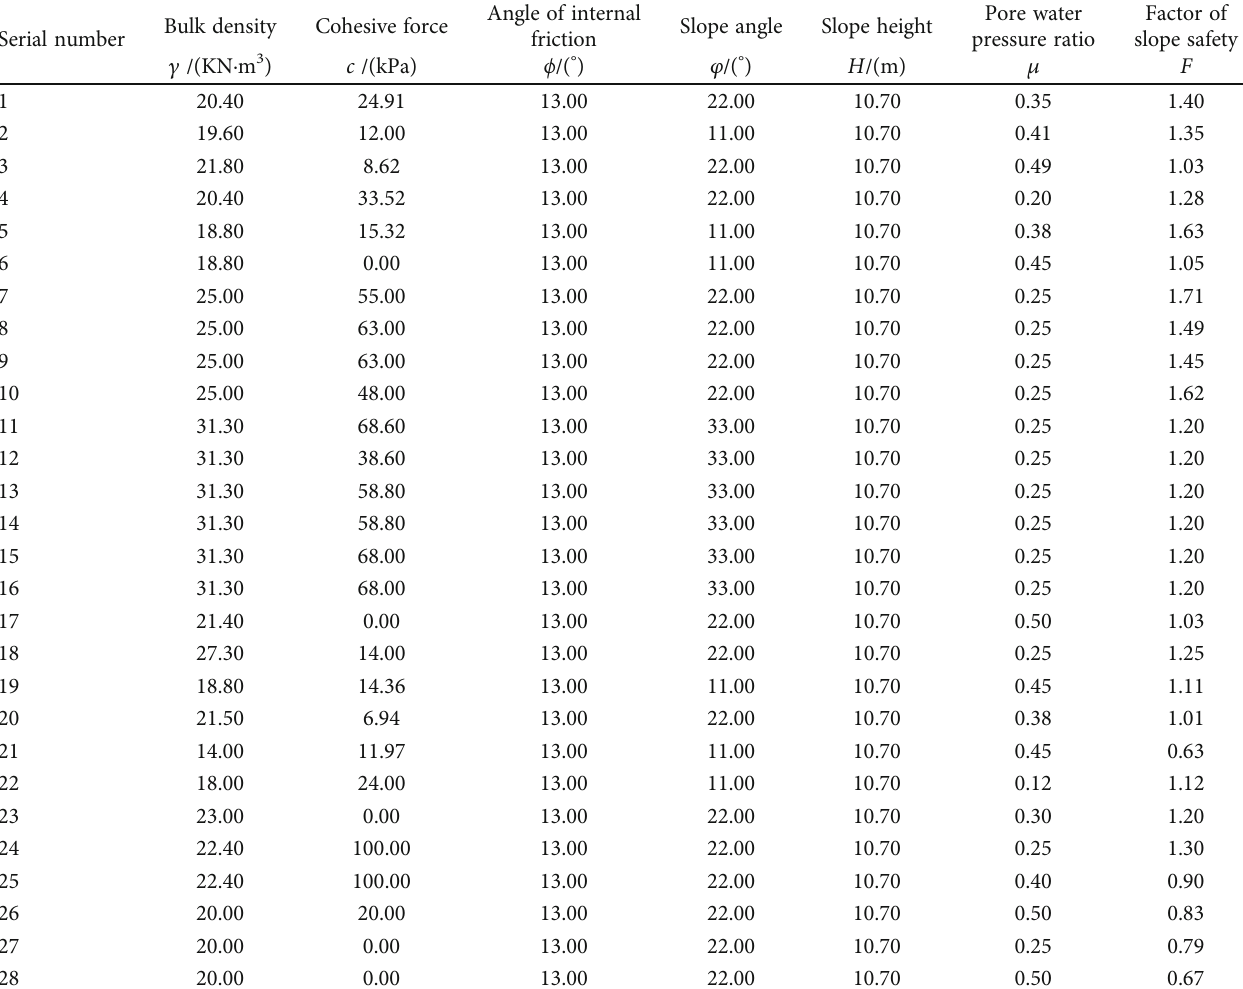
Table 1: Training data and test